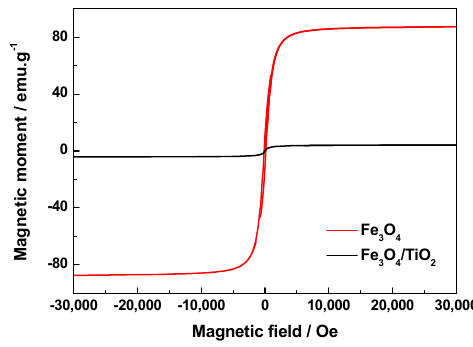
Figure 6. The magnetic hysteresis loops of Fe 3 O 4 magnetic particles and Fe 3 O 4 /TiO 2 nanocomposite.